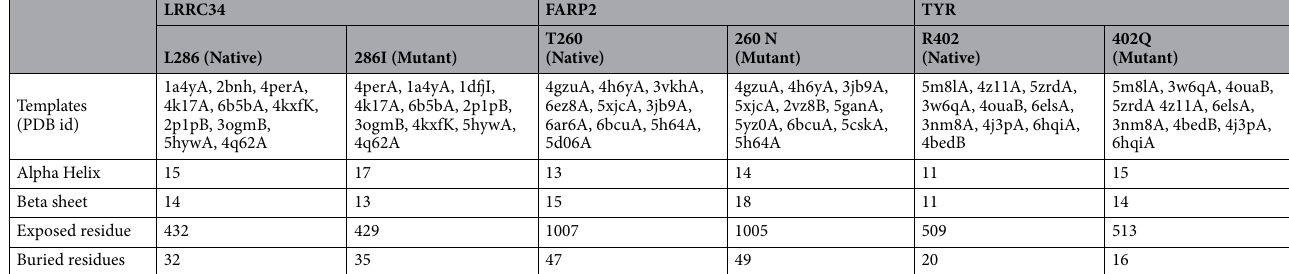
Table 6. The top 10 templates used for homology modeling, and the alpha helix, beta sheet and exposed/ buried residues used by I-TASSER.